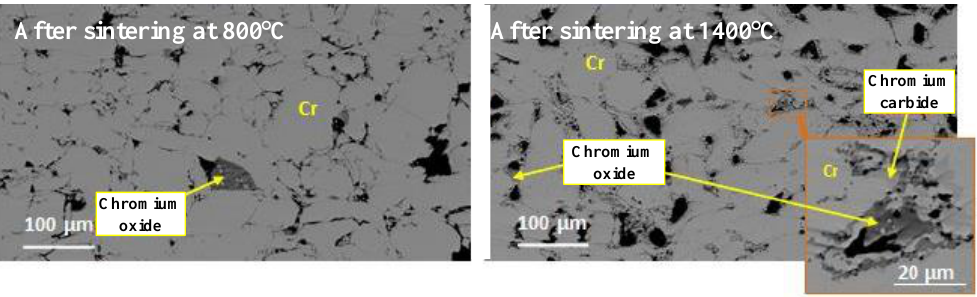
Figure 15. Micrography of a 800 mg Cr pellet after sintering and polished (SEM).